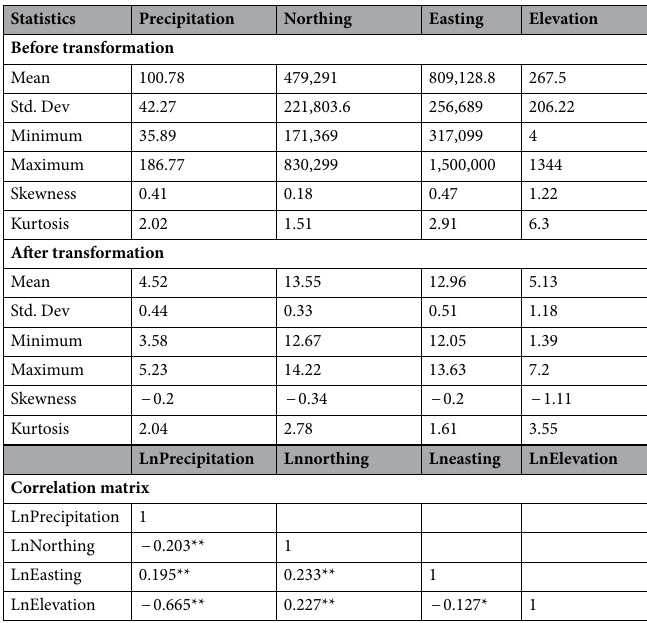
Table 2. Statistical properties of the variables. **. Correlation is significant at the 0.01 level (2-tailed) *. Correlation is significant at the 0.05 level